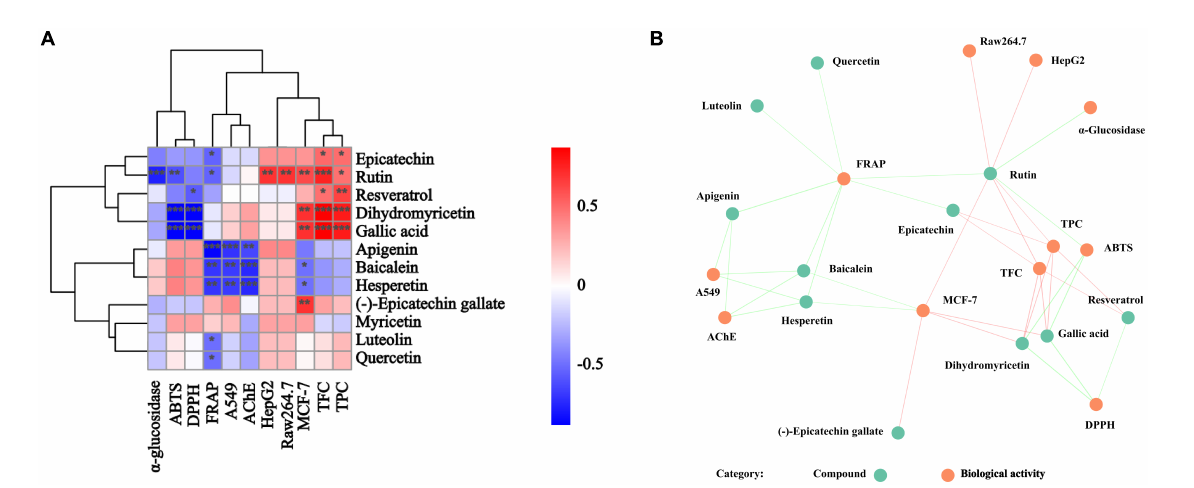
FIGURE6 Correlation analysis of individual compounds and biological activities from BCF crude extract and its fractions. P -value (ranging from –1 to 1) and corresponding color (blue to red), p < 0.05 was considered as significant (*), p < 0.01 as highly significant (**), and p < 0.001 as very significant (***). (A) Correlation heat map; (B) correlation network diagram, and each line connects the bioactivity or interphase of the compound p < 0.05.